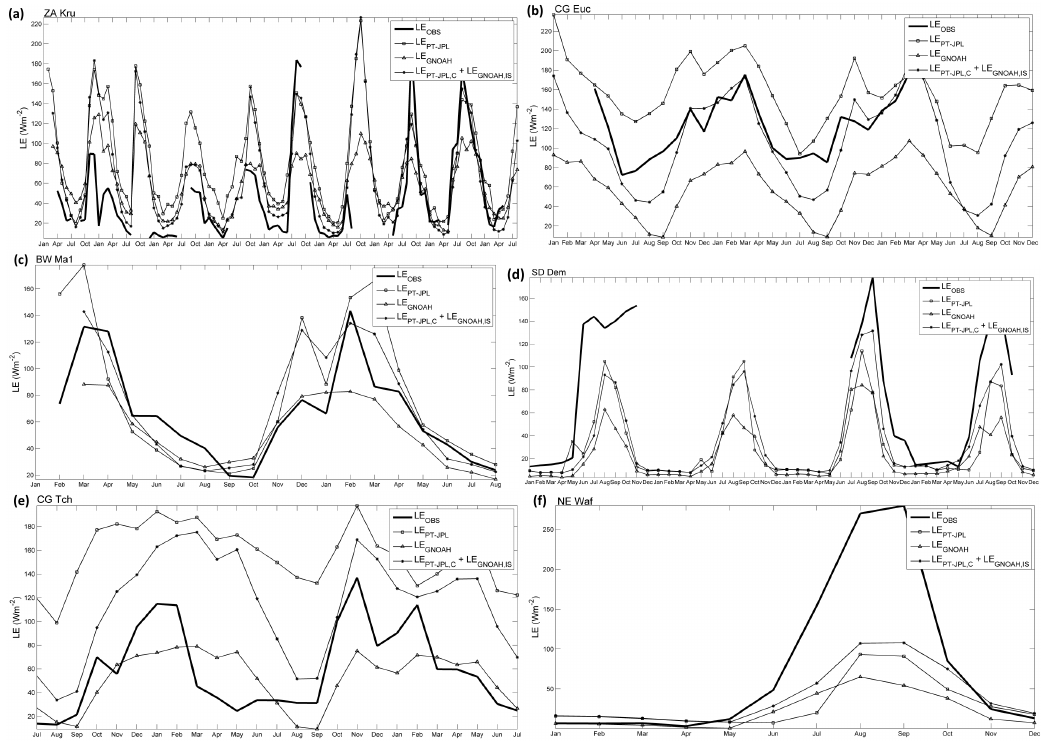
Fig. 3. Monthly time series of available LE data (–) plotted with Fisher LE ( (cid:3) ) , Noah LE ( 1 ), and Fisher LE C +GNoah LE (I,S) for ZA-Kru (a) , CG-Euc (b) , BW-Ma1 (c) , SD-Dem (d) , CG-Tch (e) , and NE-Waf (f)